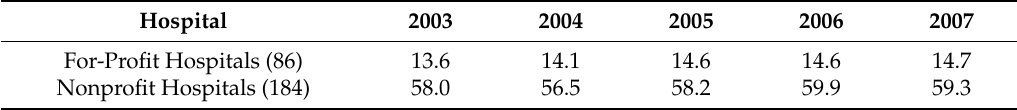
Table 3. Cumulative Market Share (Percentage) of California General Hospitals by Ownership Type.